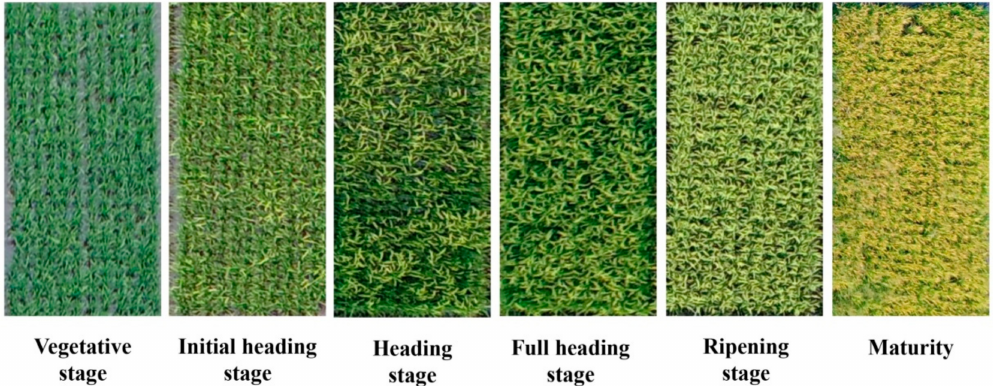
Figure 2. Detailed overview of the rice’s main phenological stages derived from UAV-RGB imagery at the flight altitude of 50 m above the